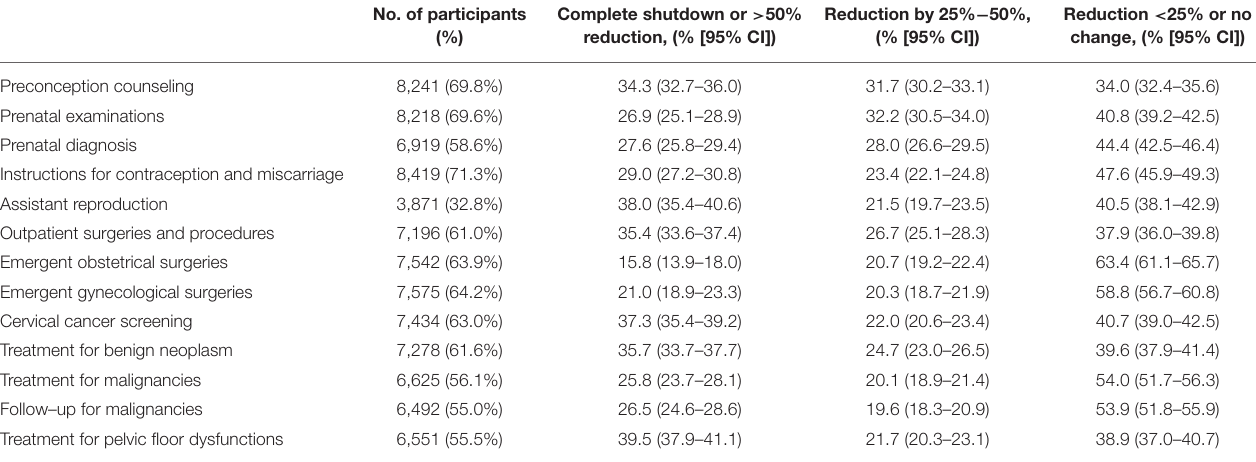
TABLE 4 | Changes in the management of specific diseases or